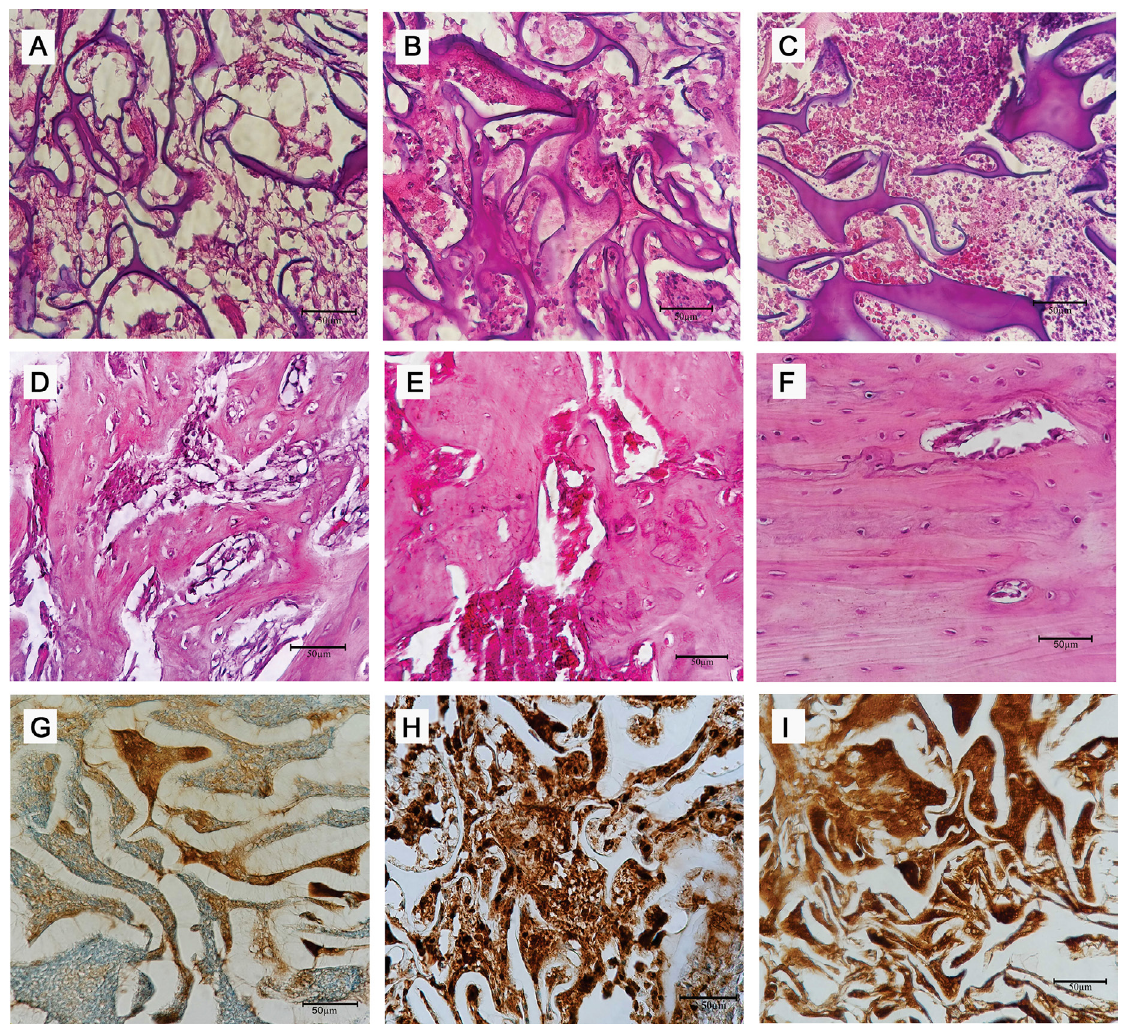
Figure 2- Photomicrographs of bone defects produced on the right tibia of animals, exemplifying the histopathologic patterns used for the allocation of scores in the semi-quantitative analysis of the acute inflammatory infiltrate (a) score 1 (b) score 2 and (c) score 3; of bone formation: (d) score 1 (e) score 2, and (f) score 3 and of osteopontin expression: (g) score 1 (h) score 2 and (i) score 3. Bar: 50